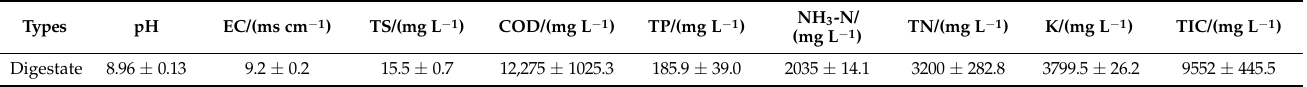
Table 1. Digestate characteristics after filtration using a 200-mesh sieve.